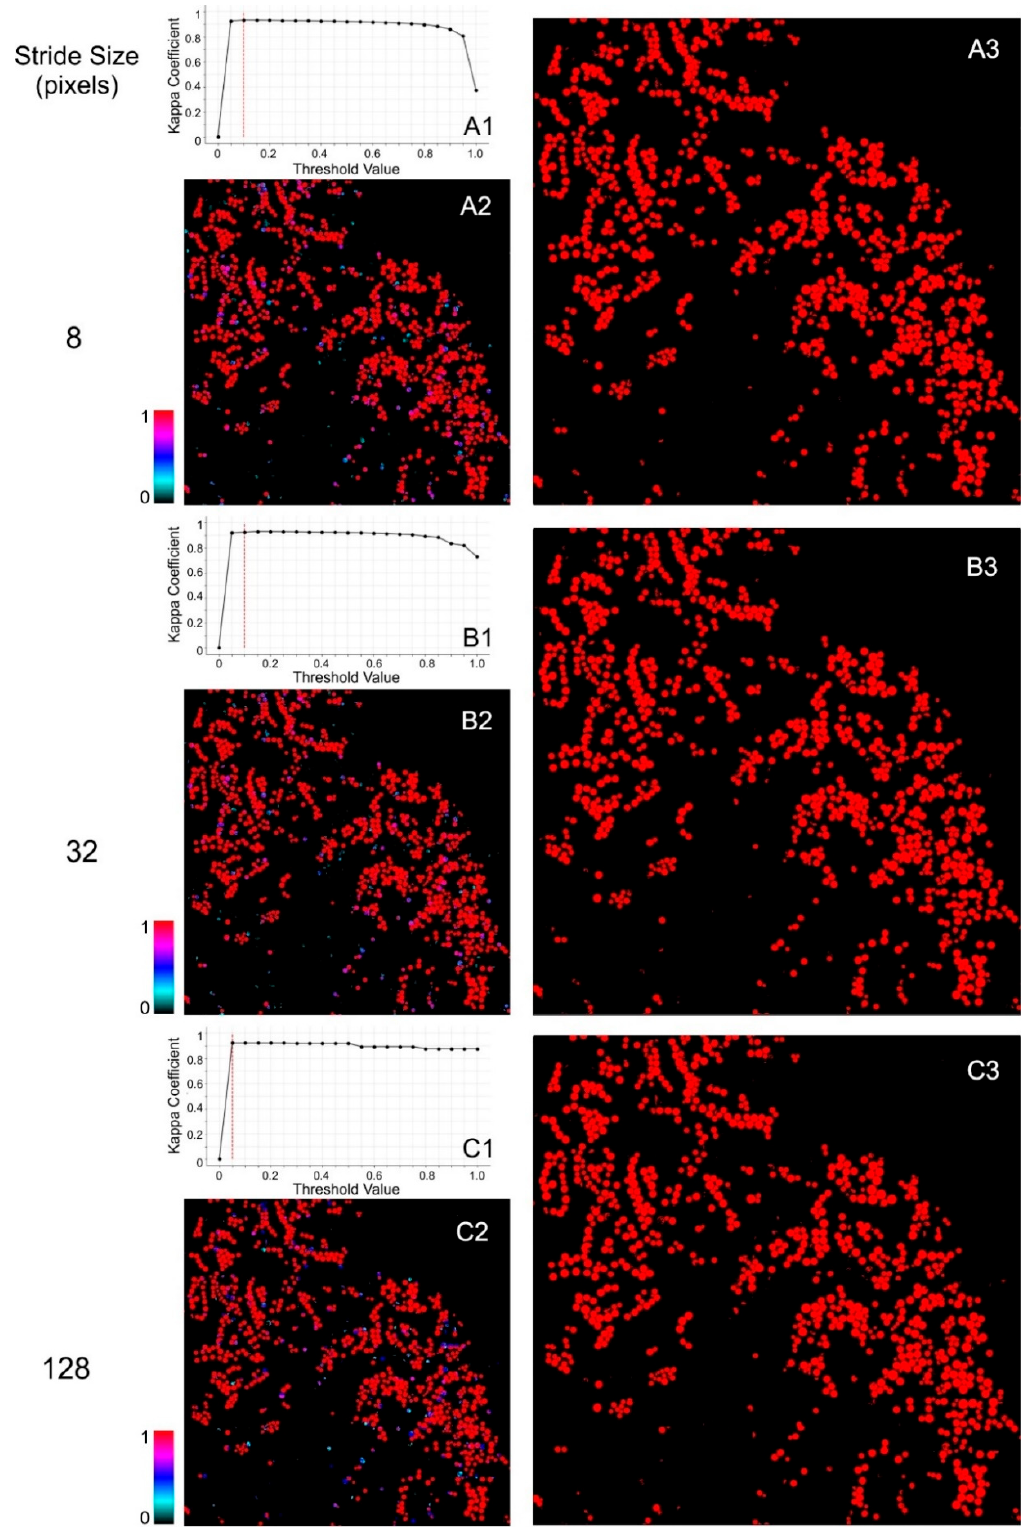
Figure 9. Classification procedures from the sliding windows with strides 8 ( A ), 32 ( B ), and 128 ( C ), considering the following components: Graphs with the Kappa coefficients for the different threshold values, where the red line shows the optimum point ( A1 , A2 , and A3 ), probability images ( B1 , B2 , and B3 ), and binary images with center pivots ( red ) and non-pivot center ( black ) ( A3 , B3 , and C3